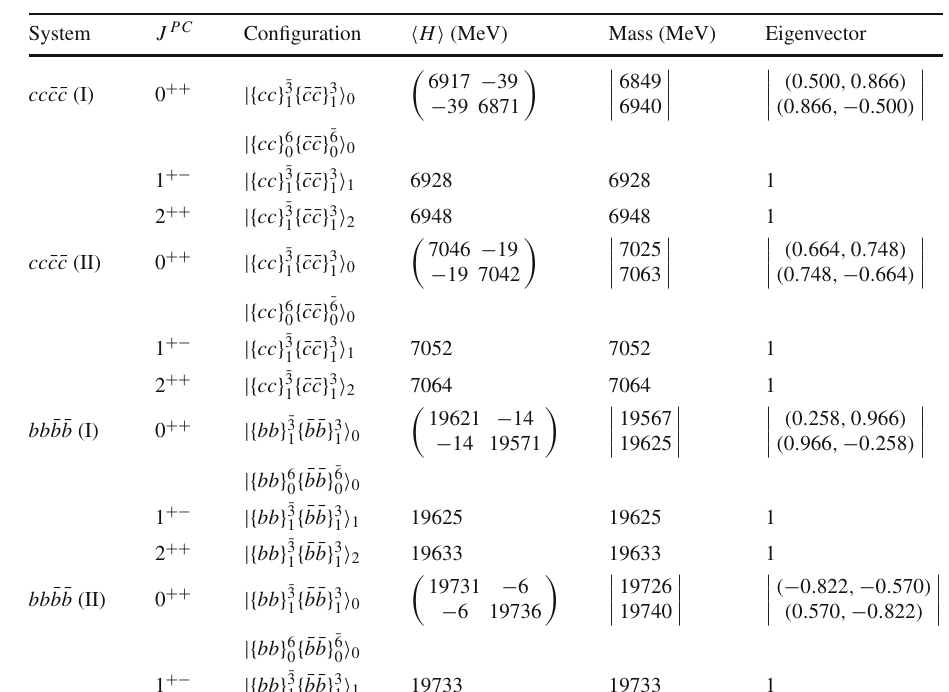
Table 4 Predicted masses of radial excitations for cc ¯ c ¯ c